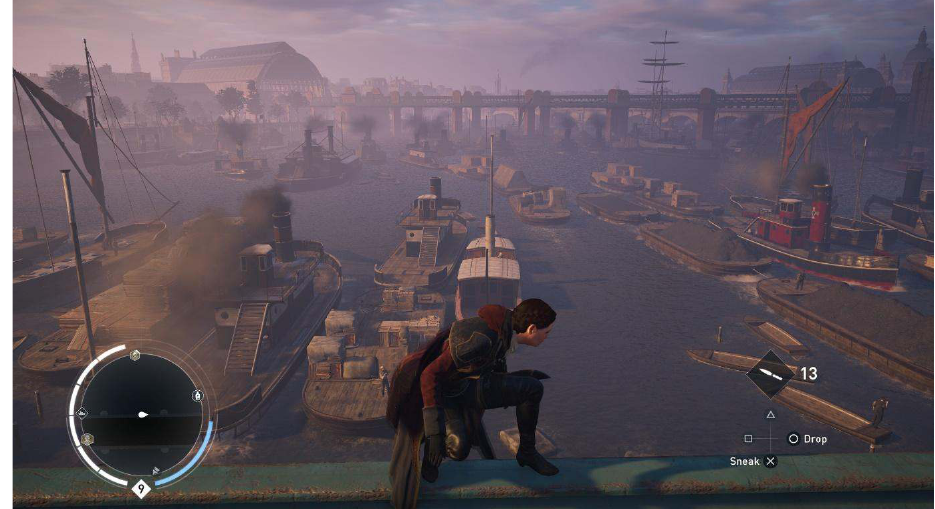
Credits: Assassin’s Creed Syndicate , Ubisoft.